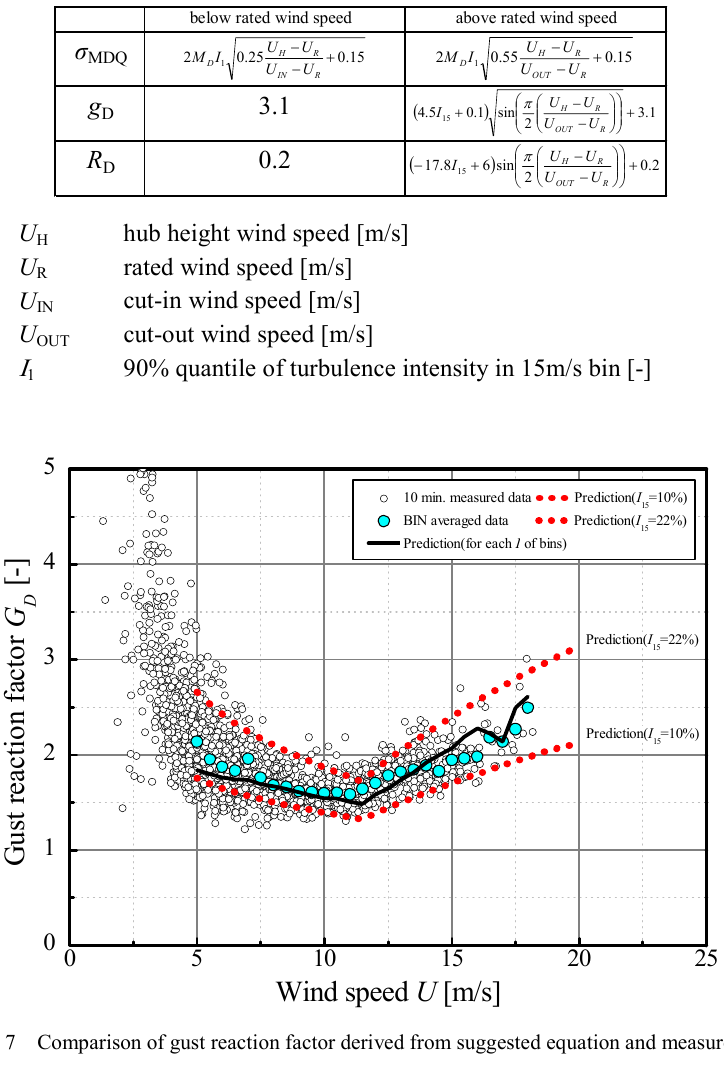
Table 2 Parameter for Gust reaction factor (Ishihara et al. (3), (4) ).